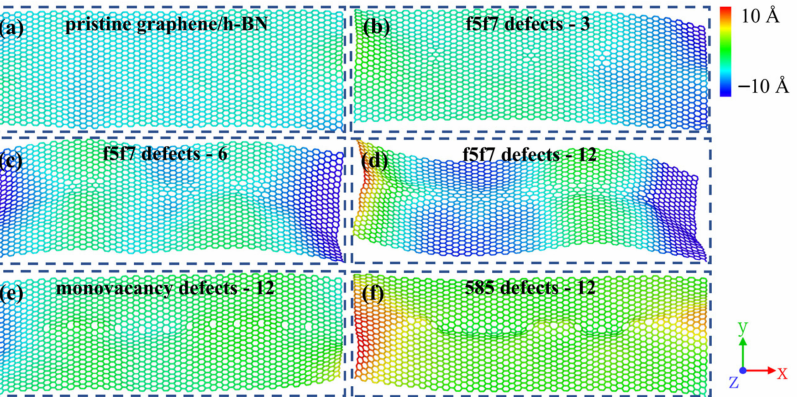
Figure 3. Wrinkles in the near-interface region of pristine graphene/h-BN and graphene/h-BN with intrinsic defects after sufficient relaxation: ( a ) pristine graphene/h-BN; ( b ) graphene/h-BN with three f5f7 double-vacancy defects; ( c ) graphene/h-BN with six f5f7 double-vacancy defects; ( d ) graphene/h-BN with twelve f5f7 double-vacancy defects; ( e ) graphene/h-BN with twelve mono- vacancy defects; ( f ) graphene/h-BN with twelve 585 double-vacancy